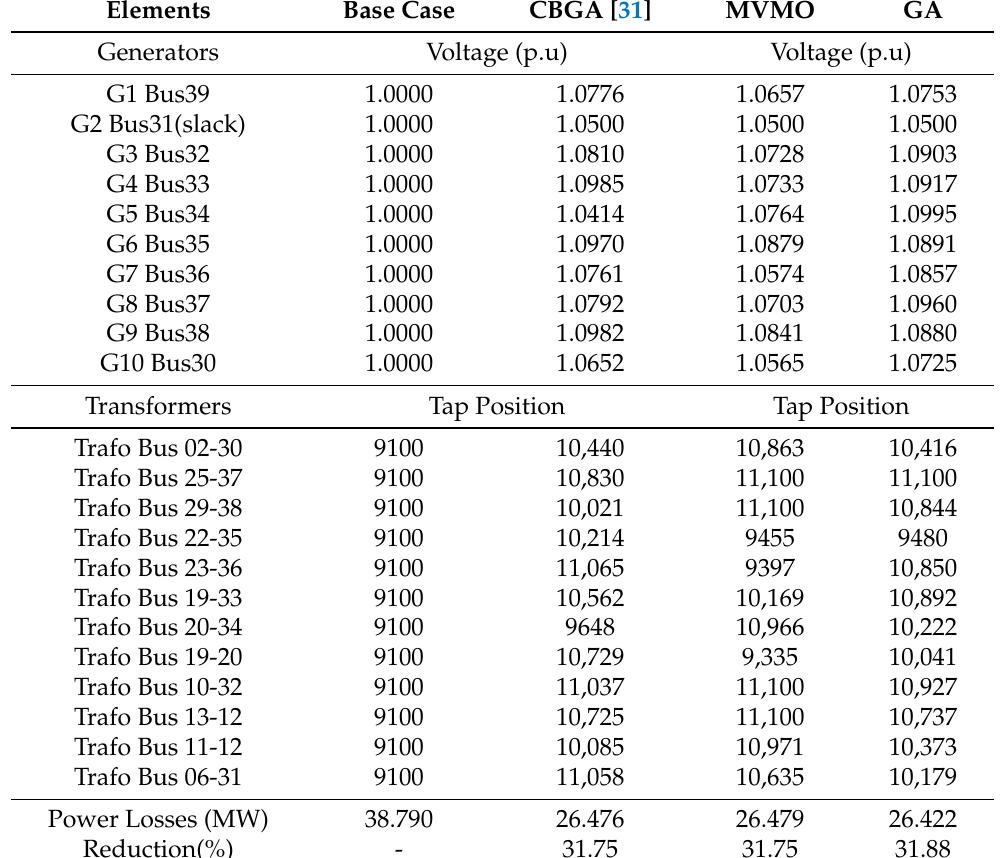
Table 12. Results for the IEEE 39-bus system.